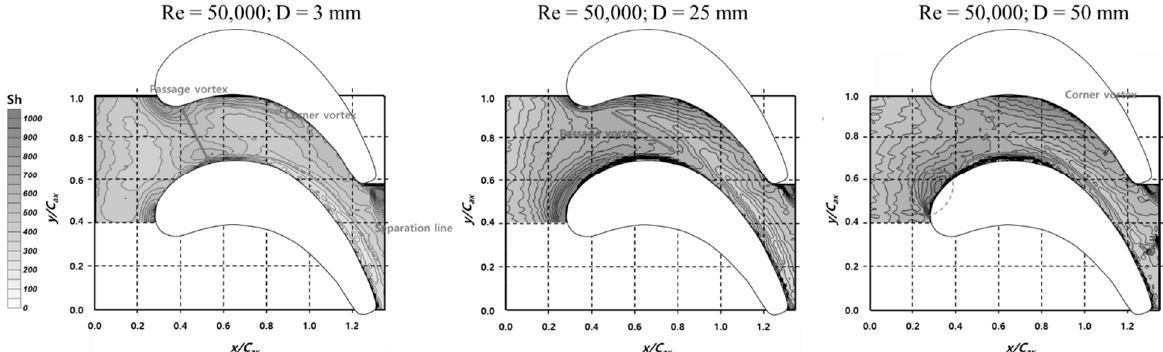
Figure 2. Mass transfer distribution on the endwall of the turbine blade from the naphthalene sublimation method [30].